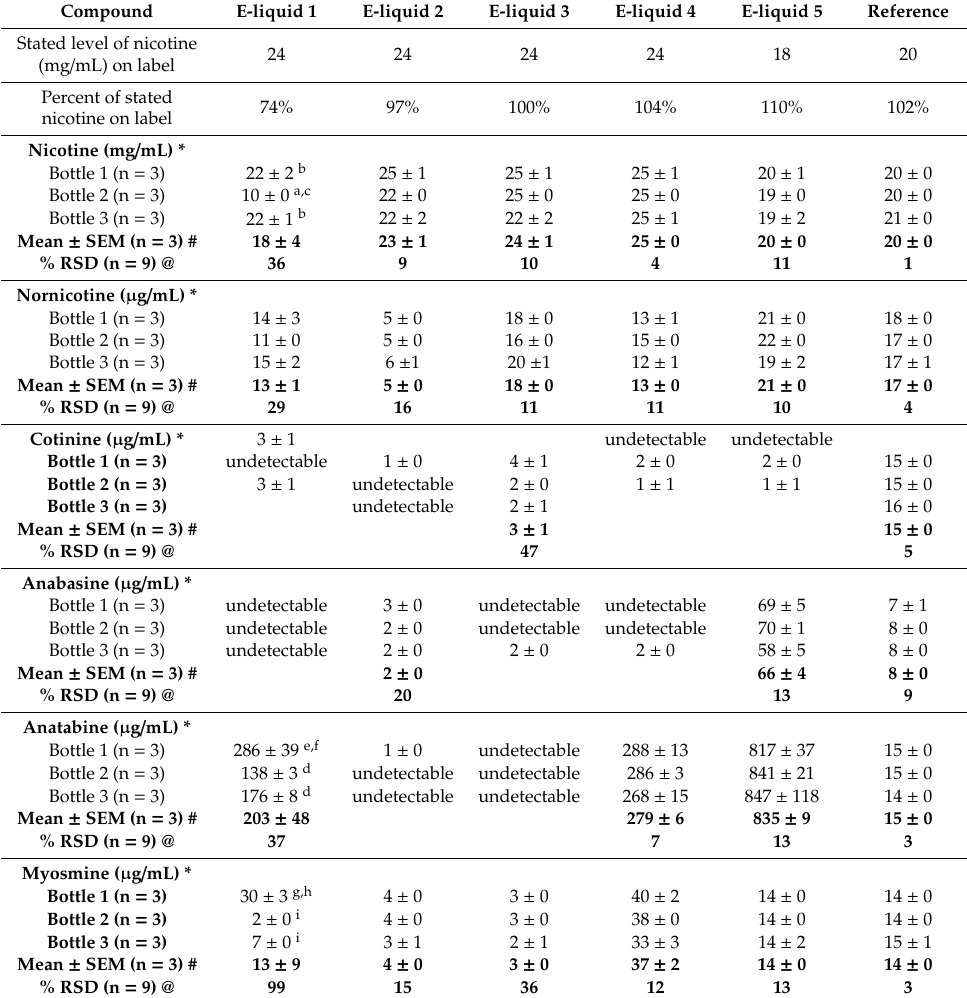
Table 3. Comparison of nicotine and nicotine-related alkaloids from various brands of E-liquid. Compound E-liquid 1 E-liquid 2 E-liquid 3 E-liquid 4 E-liquid 5 Reference